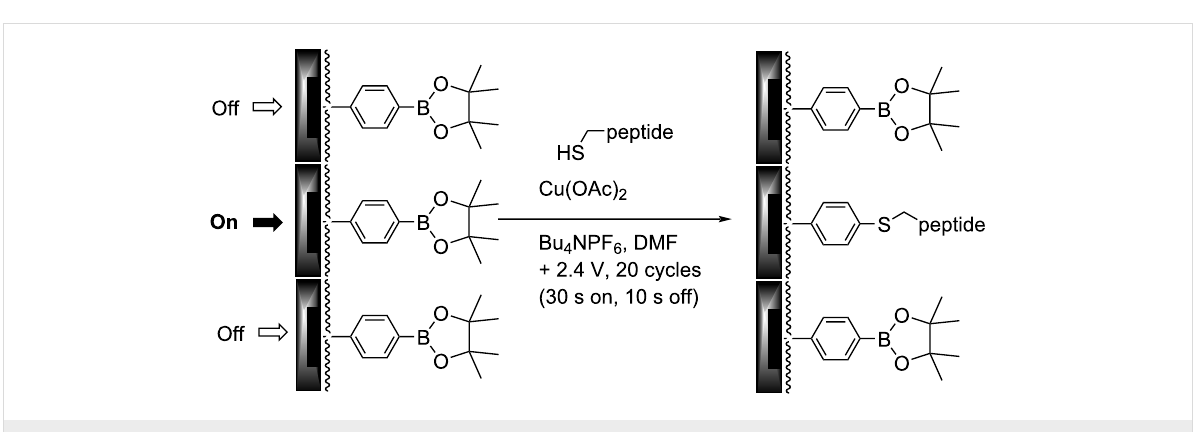
Scheme 2: An array-based Chan–Lam coupling reaction.